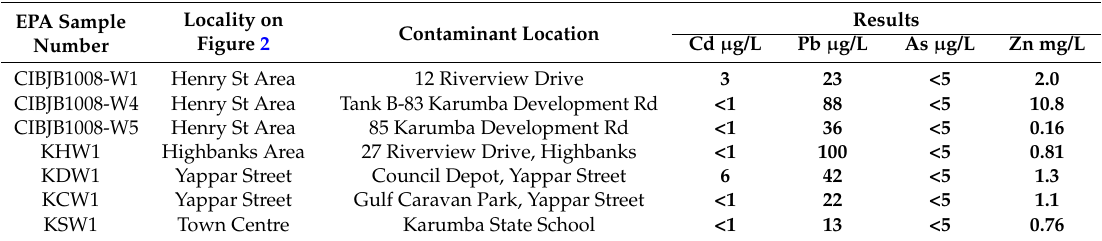
Table 2. Rain Water Tank Water Samples.